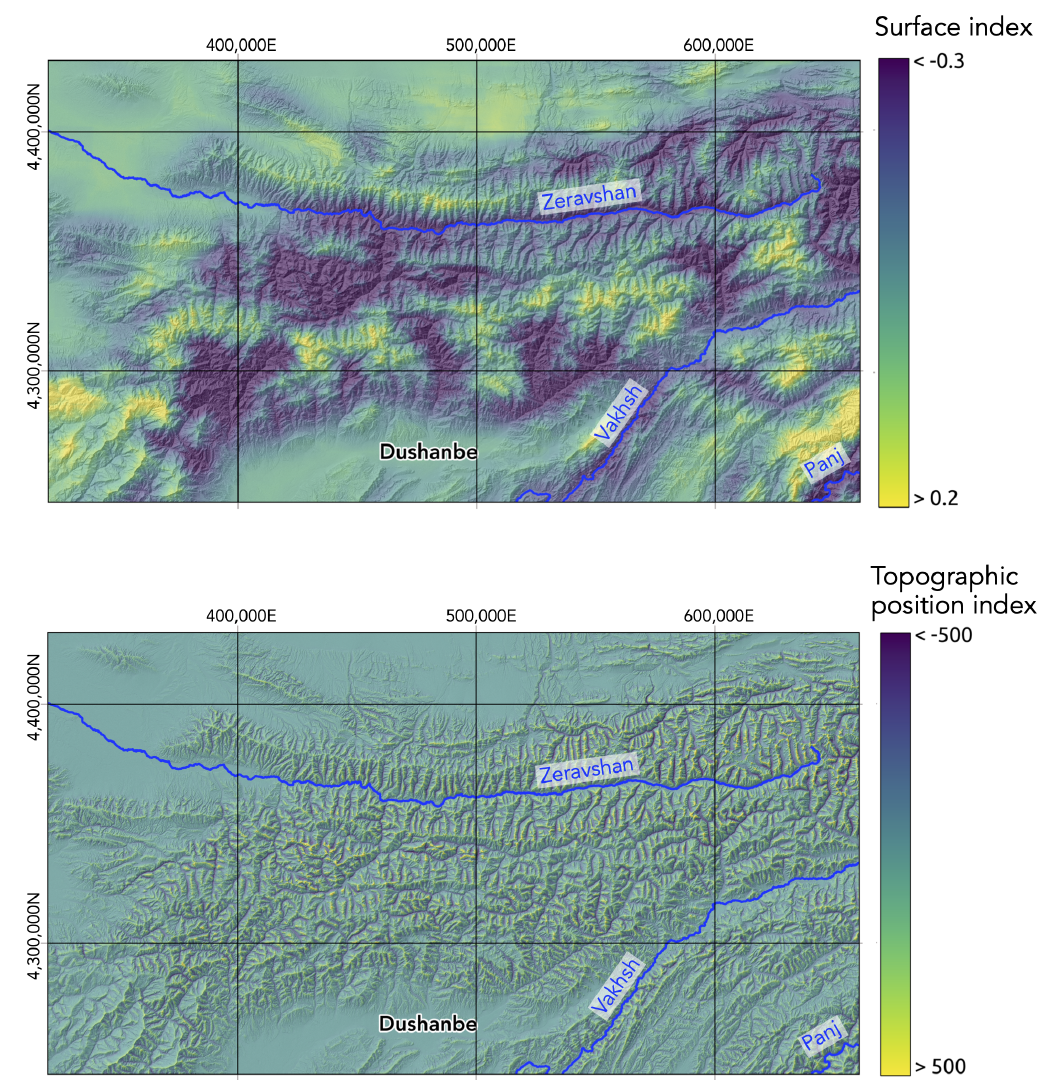
Figure A6. Window-based morphometric indices calculated with their most important observation window, i.e., Local relief: 12,775m; surface roughness: 4775m; hypsometric integral: 7775m; surface index: 12,775m; topographic position index: